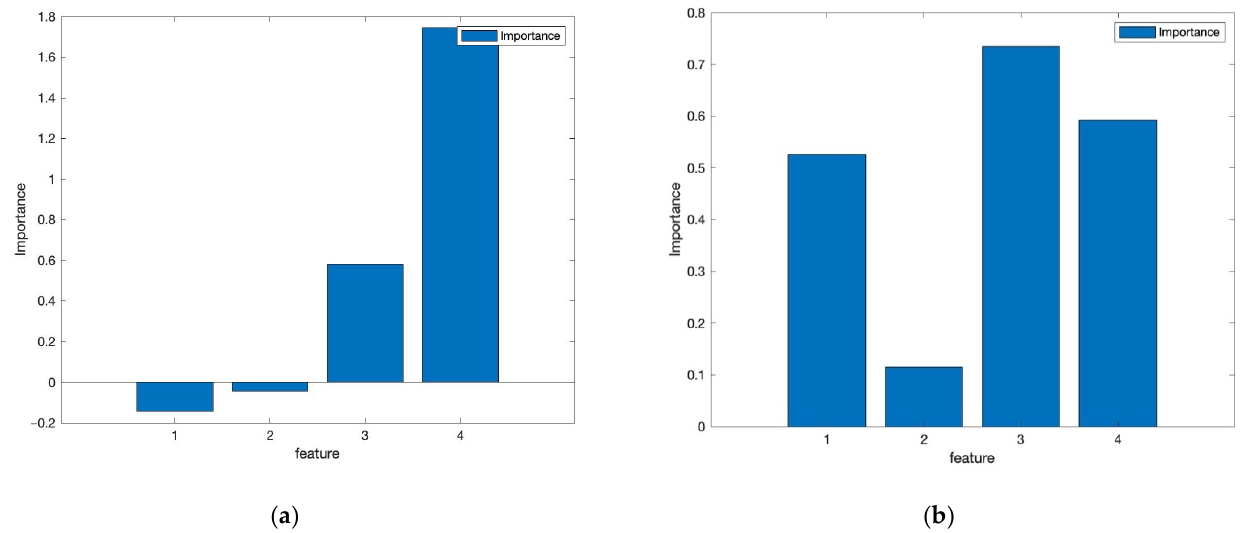
Figure 2. ( a ) is the result of the analysis of decision variables for surface bond strength, and ( b ) is the result of the analysis of decision variables for surface roughness.